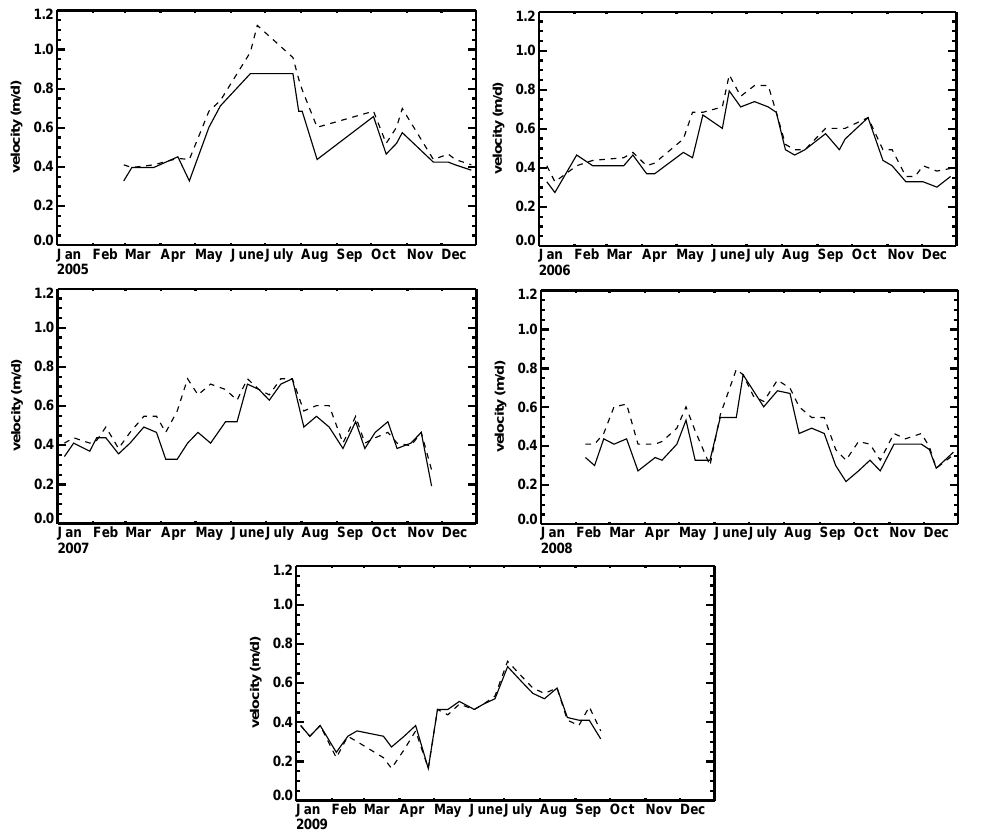
Fig. 15. Flow velocities for two points in the steep part of Triftgletscher from 2005 to 2009 (dashed line: point 1; solid line: point 2, see Fig. 14).